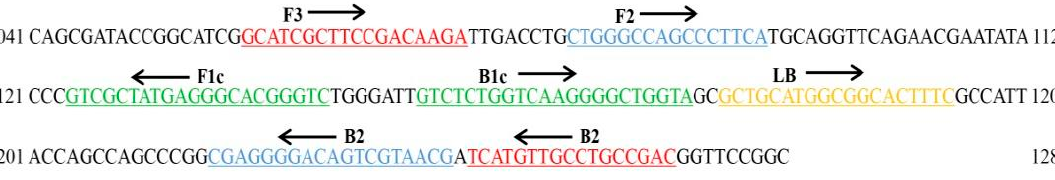
Figure 11. Location of LAMP-specific primers in corresponding genes.